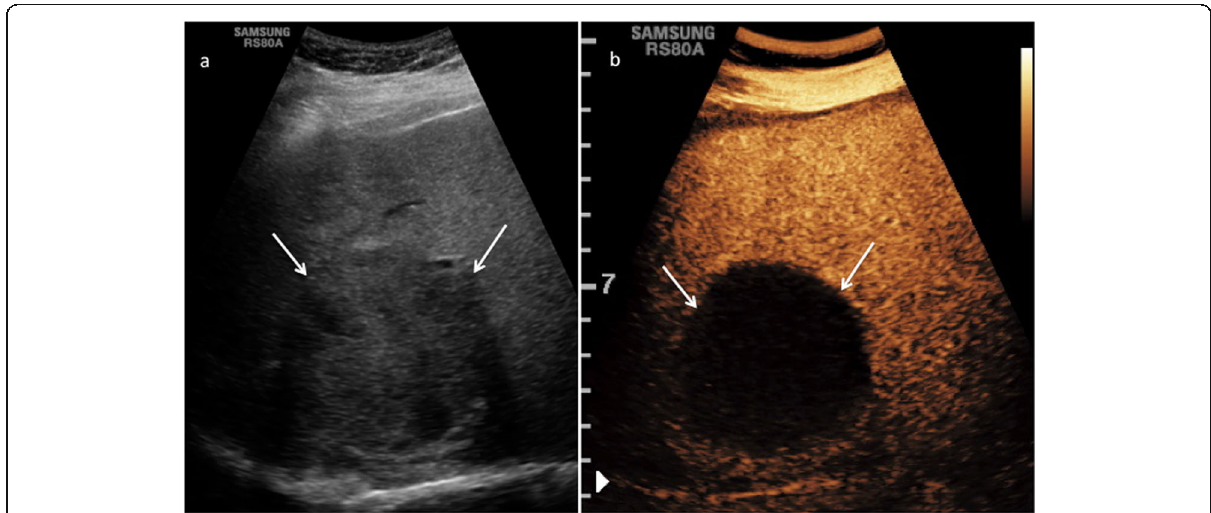
Fig. 2 CEUS LI-RADS 1 (definitely benign). Complex cyst in a 60-year-old woman with chronic hepatitis B viral infection. Baseline US image ( a ) shows a heterogeneous and moderately hypoechoic lesion sized 6.2 cm in the segment VI – VII (arrows). At CEUS ( b ), the lesion shows a complete lack of enhancement throughout the vascular phases